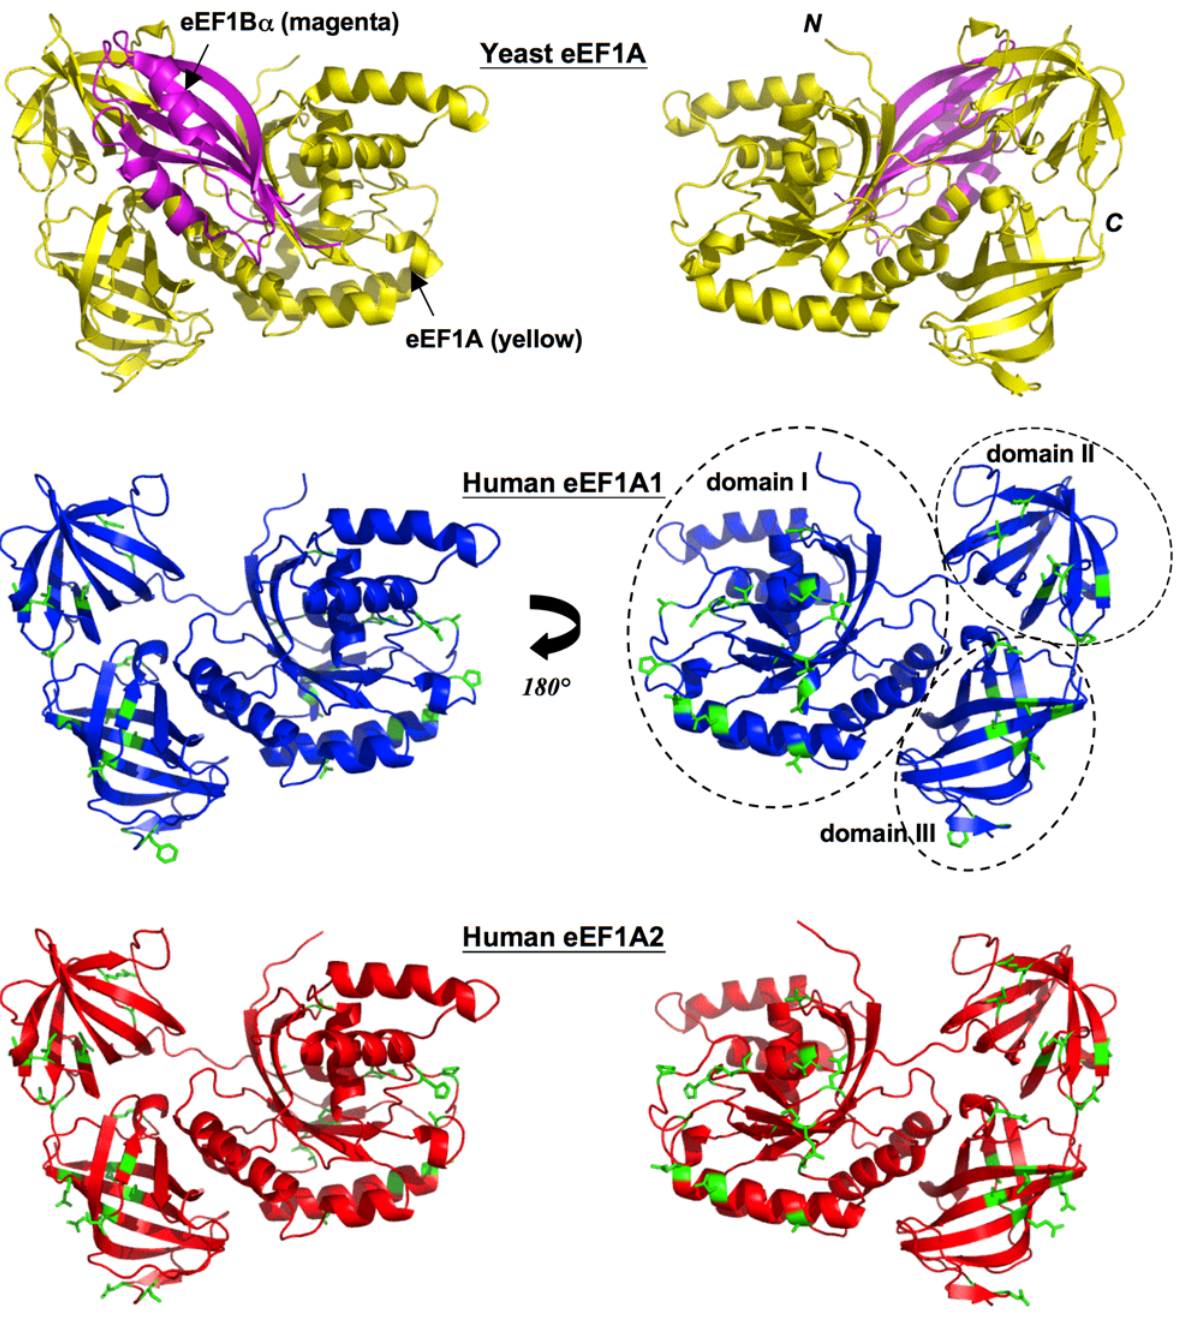
Figure 2. Yeast template, human eEF1A1 and eEF1A2 models. Two views rotated by 180 u about the y -axis depicting cartoon schematic representations of: the yeast eEF1A (yellow)-eEF1B a C-terminal fragment (magenta) crystal structure (top panel). The 3-D models of eEF1A1 (blue, middle panel), and eEF1A2 (red, lower panel) show the location of variant side-chains (in stick representation) between the two proteins, colored green. Secondary structure elements have been assigned by default settings in PyMol (http://www.pymol.org) and position of domains labeled.